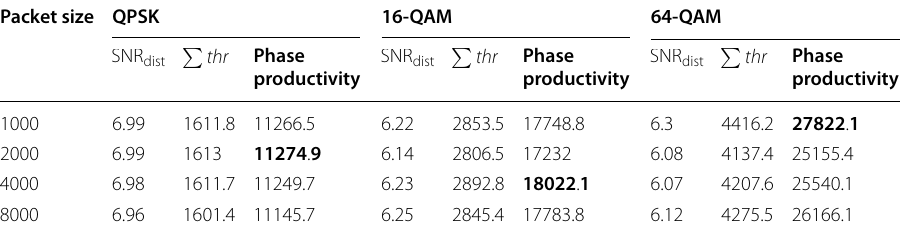
Table 11 Phase productivity for different packet sizes and modulations in the proposed MDP‑CLLA model Packet size